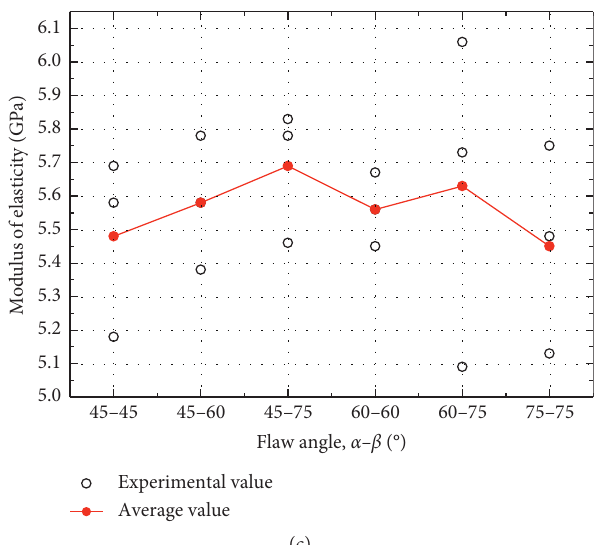
Figure 6: The effects of the orientation of flaws with the same area on the strength and deformation parameters of specimens containing two parallelogram flaws. (a) Peak strength. (b) Peak strain. (c) Modulus of